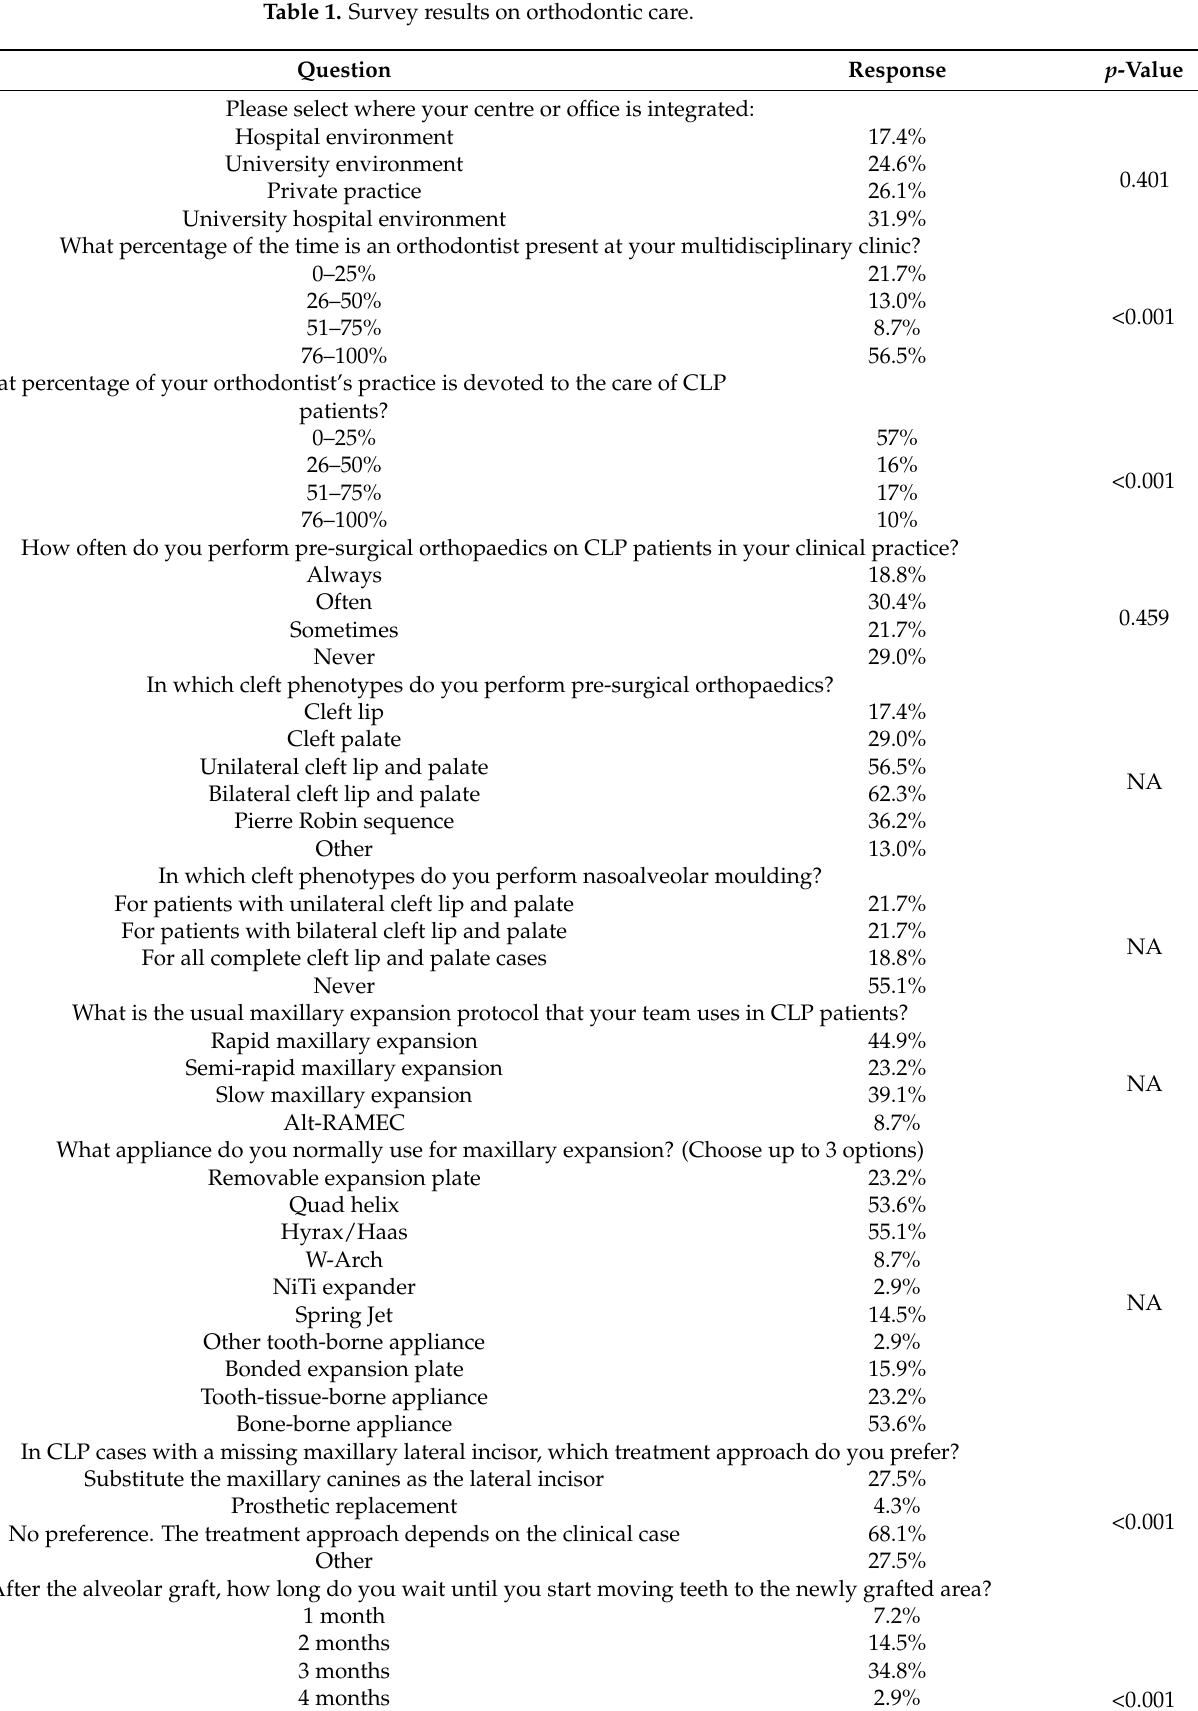
Table 1. Survey results on orthodontic